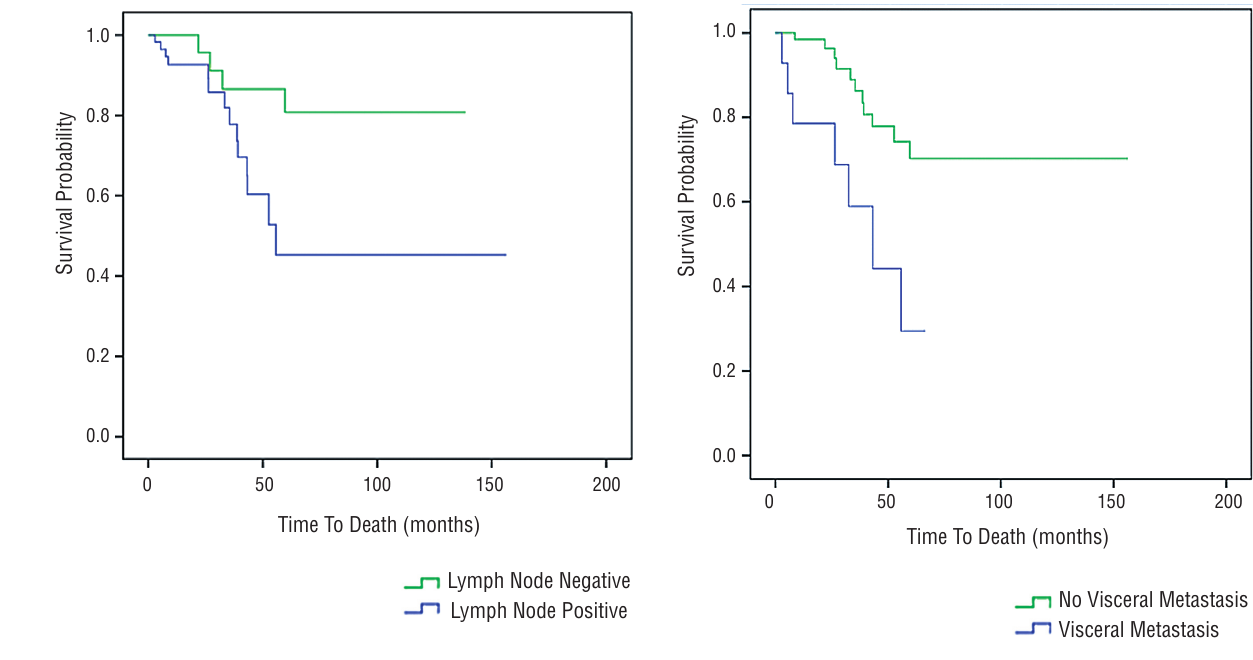
Figure 3 - Kaplan-Meier Survival Visceral Metastasis Curve.Figure 2 - Kaplan-Meier Survival Lymph Node Positive